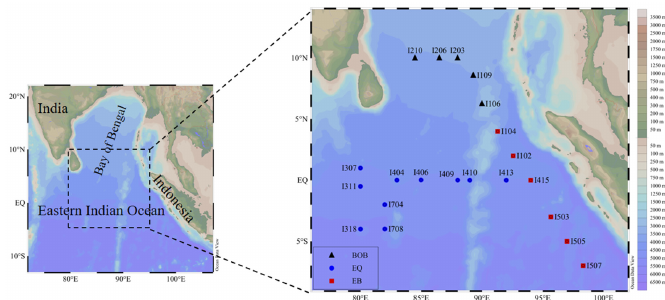
Figure 1. Maps of the study area and the distribution of sampling stations (BOB: Bay of Bengal; EQ: Equator; EB: Eastern Boundary).